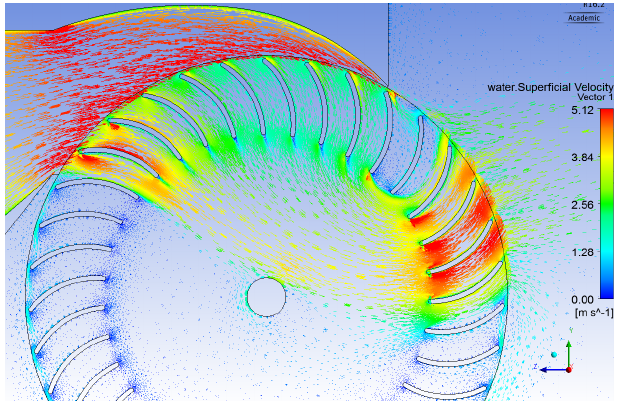
Figure 10. Water velocity vectors illustrating the reduction in flow separation in the runner of the 7 kW turbine with the new nozzle and improved runner design at η max = 91%. Q = 105 lps, H = 10 m, and N = 500 RPM. Note that there is a significant reduction in flow separation on the blades [5].